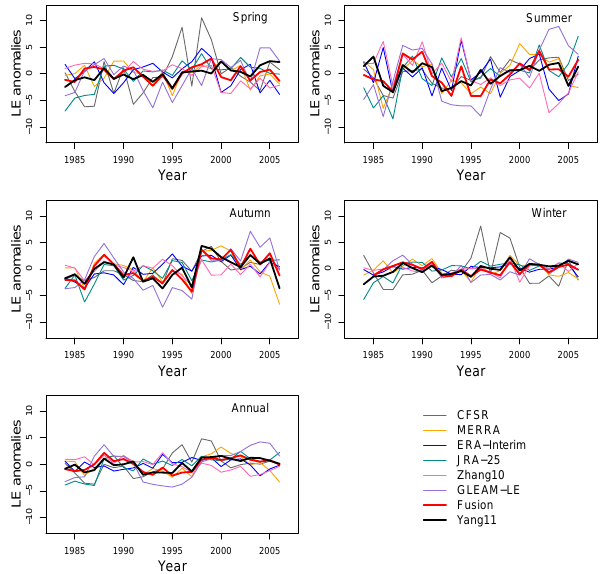
Figure 5. Anomalies of latent heat flux from multiple data sets and fused data with ground measurement averaged for all available CMA stations (units are Wm − 2 ).